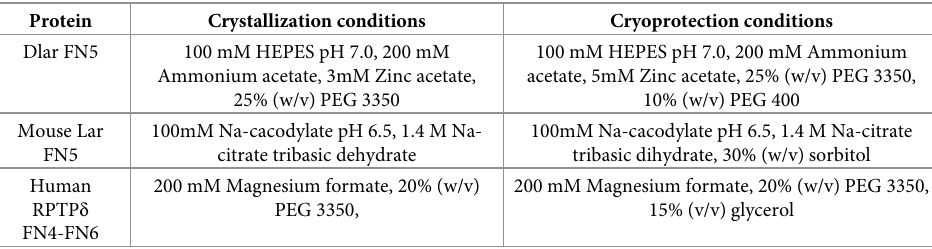
Table 1. Crystallization and cryoprotection conditions.